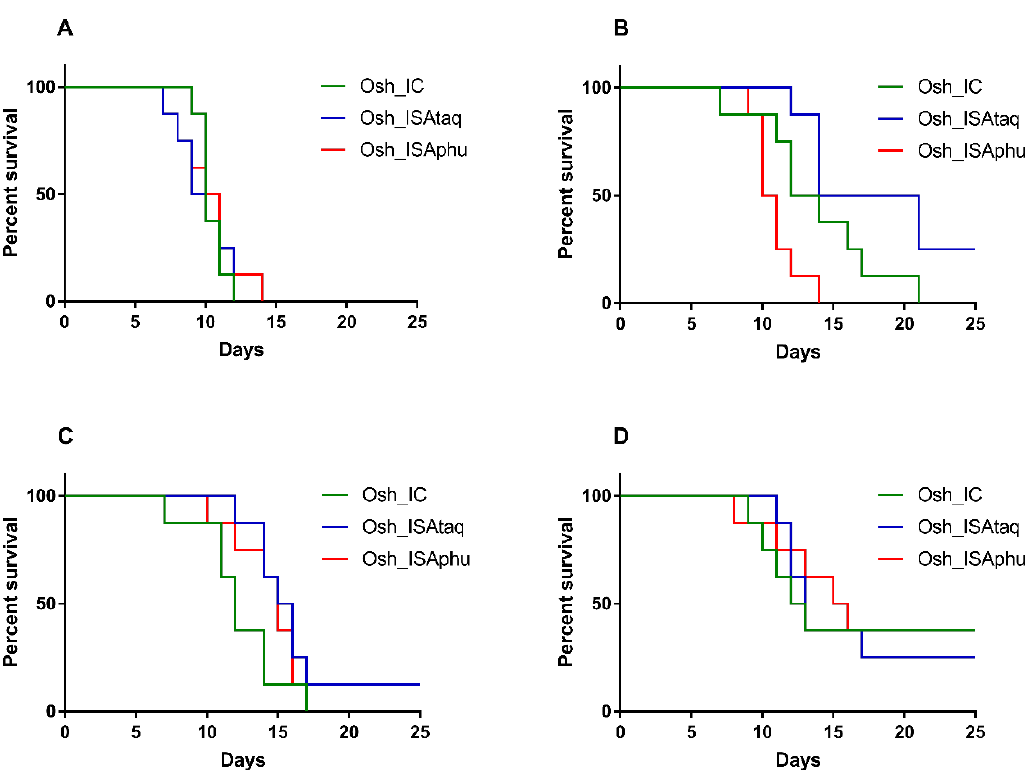
Figure 5. Survival curves according to the dose of virus inoculated. Group of eight mice were intra-peritoneally inoculated with 2 × 10 5 ( A ), 2 × 10 4 ( B ), 2 × 10 3 ( C ), or 2 × 10 2 ( D ) TCID 50 of each virus. Survival curves were established based on human endpoints.